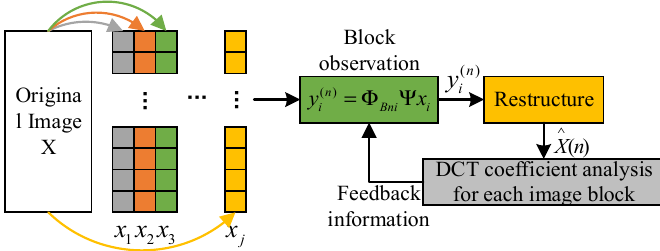
Figure 6. Image encoding and hiding